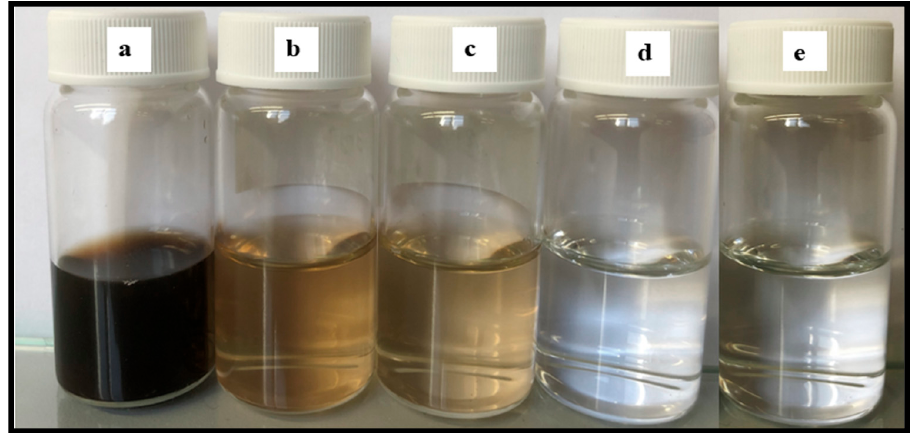
Figure 10. Rejection of HA solution and permeate turbidity: ( a ) feed humic acid solution of 100 mg/L. ( b ) Permeate of PTFE, MD. ( c ) Permeate of PTFE, AS-MD. ( d ) Permeate of CNIM, MD. ( e ) Permeate of CNIM, AS-MD.